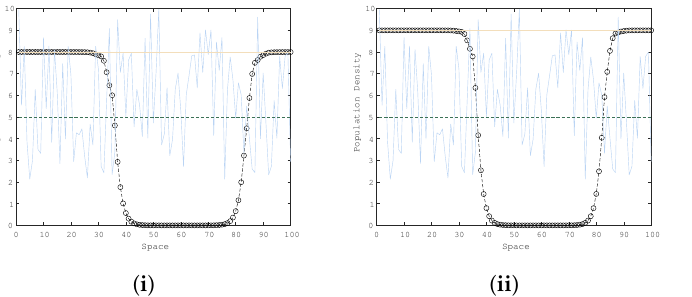
Figure 4. Variation of subpopulation size over space with a large coupling q = 20 obtained for β = 8 in ( i ) and β = 9 in ( ii ).